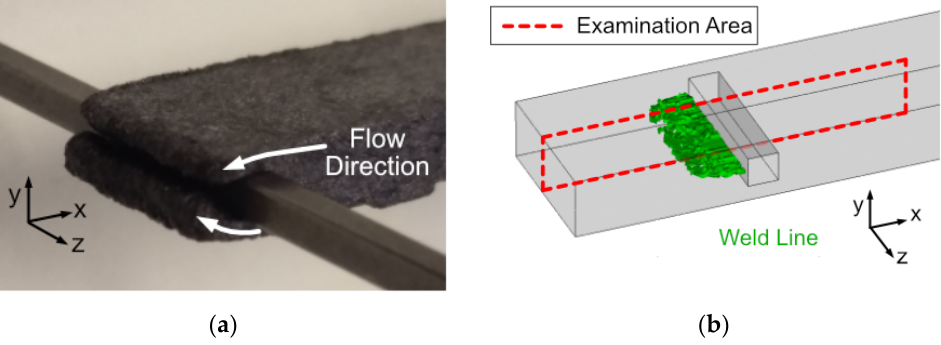
Figure 8. ( a ) Melt front dividing irregularly at the pin area of an injection molded sample (PC CF20); ( b ) representation of the emerging weld line at the pin area obtained from injection molding simu- lation.